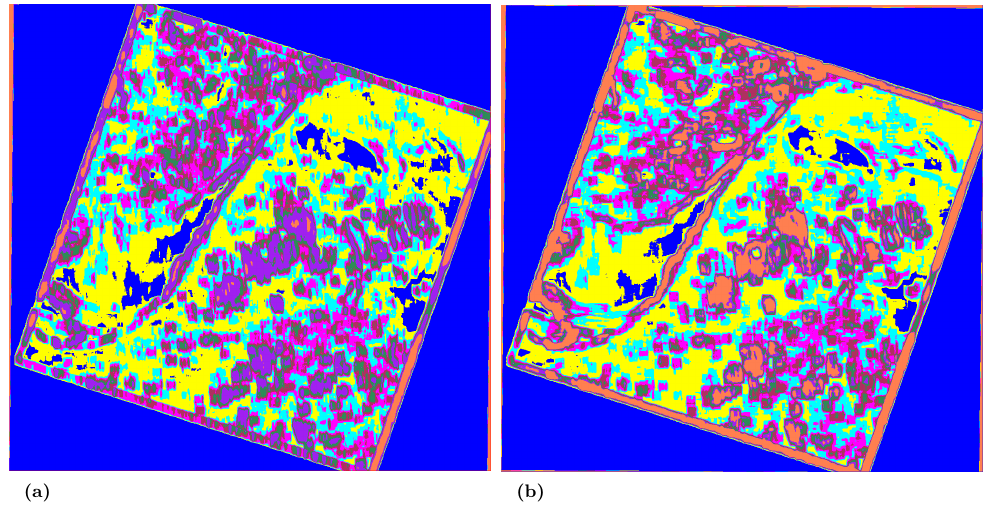
Figure 10. Sea-ice classification for ERS-2 SAR data of Barrow area in Figure 4. Result of unsupervised classifications based on vario parameter maps (Figure 9a–e). ( a ) Result of an unsupervised classification based on 4 parameter maps ( pond , mindist , p 1, p 2, window size 20, direction 0 ◦ ) and 10 sea-ice class types (using KMEANS routine in ENVI with a threshold of 5 % pixel value change to stop iterations; stopped after 3 iterations); ( b ) Result of supervised classification based on 8 parameter maps ( pond , mindist , p 1, p 2, window size 20, directions 0 ◦ and 90 ◦ ) and 10 sea-ice class types (using KMEANS routine in ENVI with a threshold of 5% pixel value change to stop iterations; stopped after 1 iteration). KMEANS implements the “k-means" multi-variate statistical clustering technique. Land areas masked for